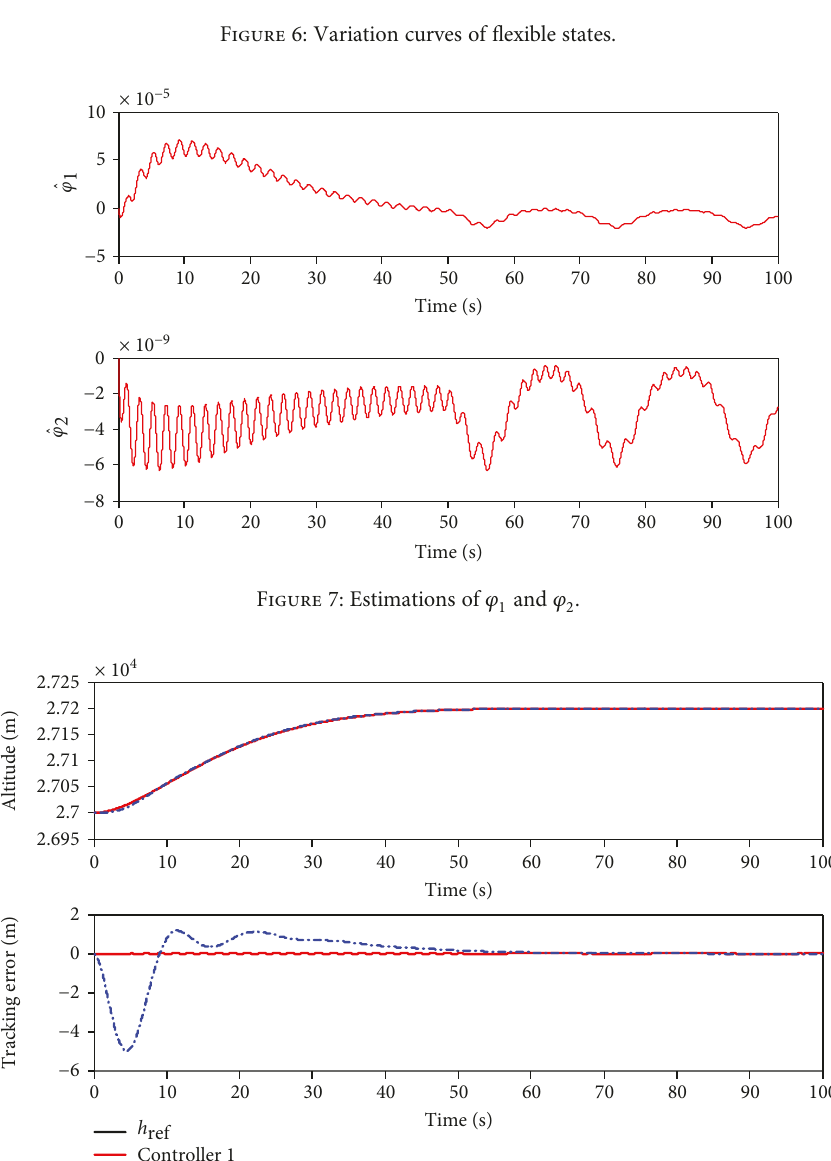
Figure 8: Altitude tracking